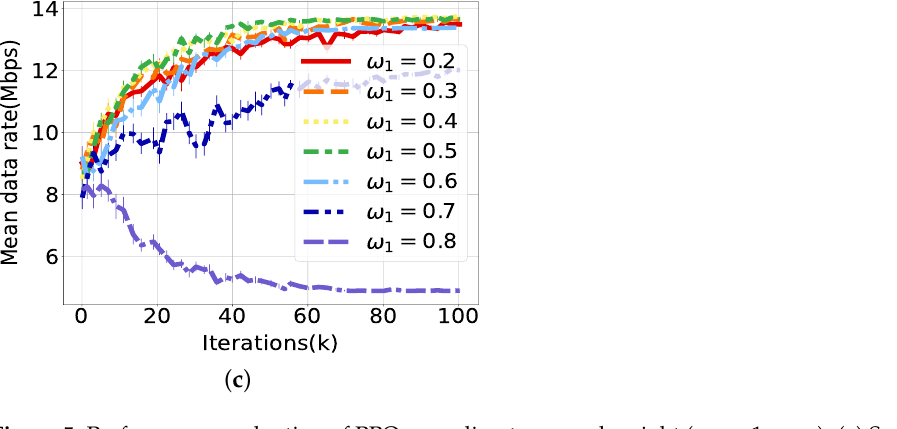
Figure 5. Performance evaluation of PPO according to reward weight ( ω 2 = 1 − ω 1 ). ( a ) Scalarized reward. ( b ) Energy savings. ( c ) Average data rate per UE.